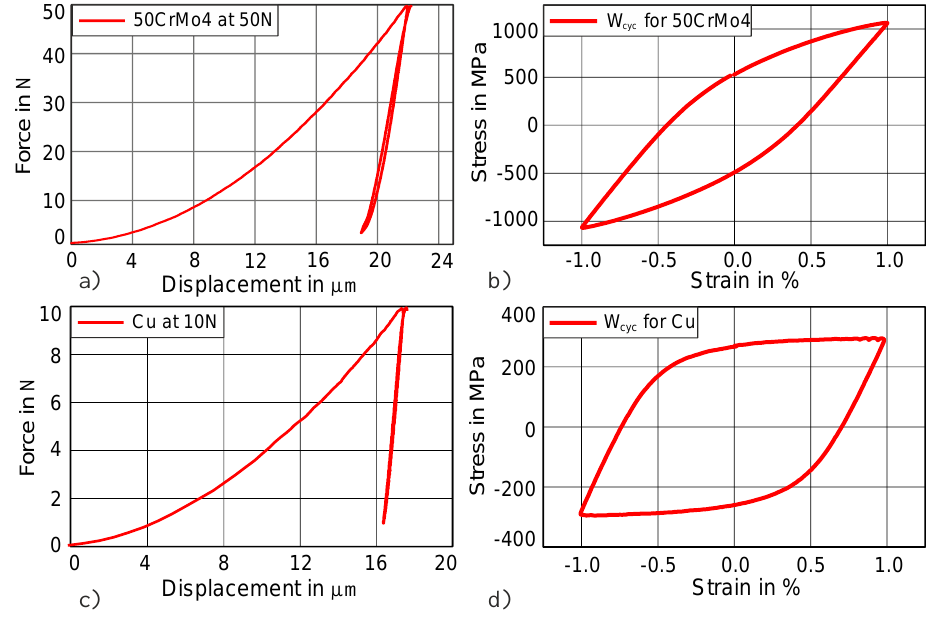
Figure 1. Experimental results for Cu and 50CrMo4: ( a ) indentation cycle at 50 N for 50CrMo4; ( b ) stress–strain from fatigue experiments of 50CrMo4; ( c ) indentation cycle at 10 N for Cu ( d ) Stress–strain from fatigue experiments of Cu.